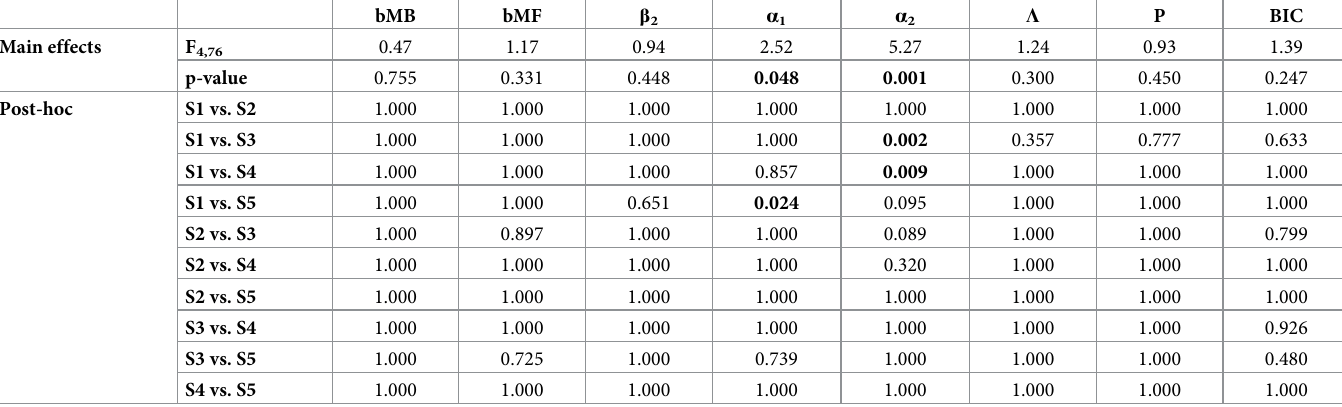
Table 3. Model parameters. Training effects on the seven parameters (bMB, bMF, β 2 , α 1 , α 2 , λ , p ) and BIC assessed using repeated measures ANOVA. See Fig 5 for